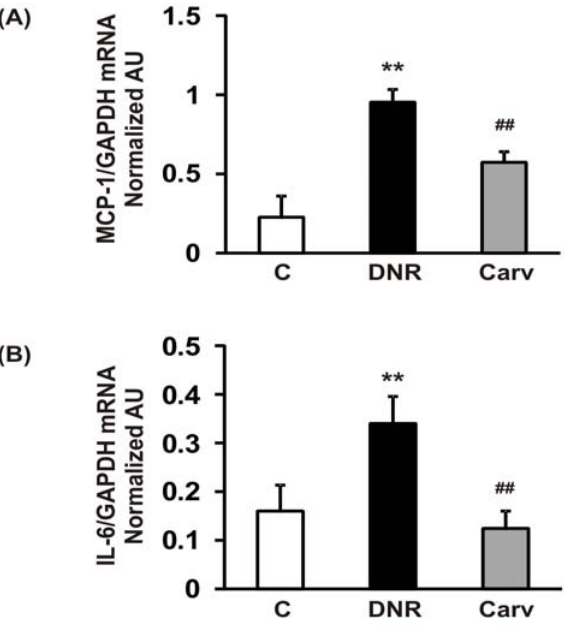
Figure 4 . Myocardial messenger RNA expression levels of MCP-1 (A) and IL-6 (B) in DNR-rats were determined by quantitative RT-PCR. The expression level of each sample was expressed relative to the expression level of GAPDH gene. The white, black and grey bars, respectively, represent the control (age-matched normal rats), DNR (DNR-treated rats administered with vehicle) and the Carv (DNR-treated rats administered with carvedilol (30 mg/kg/day)) group. Each bar represents mean ± S.E.M. ** p < 0.01 vs. group Control; ## p < 0.01 vs. group